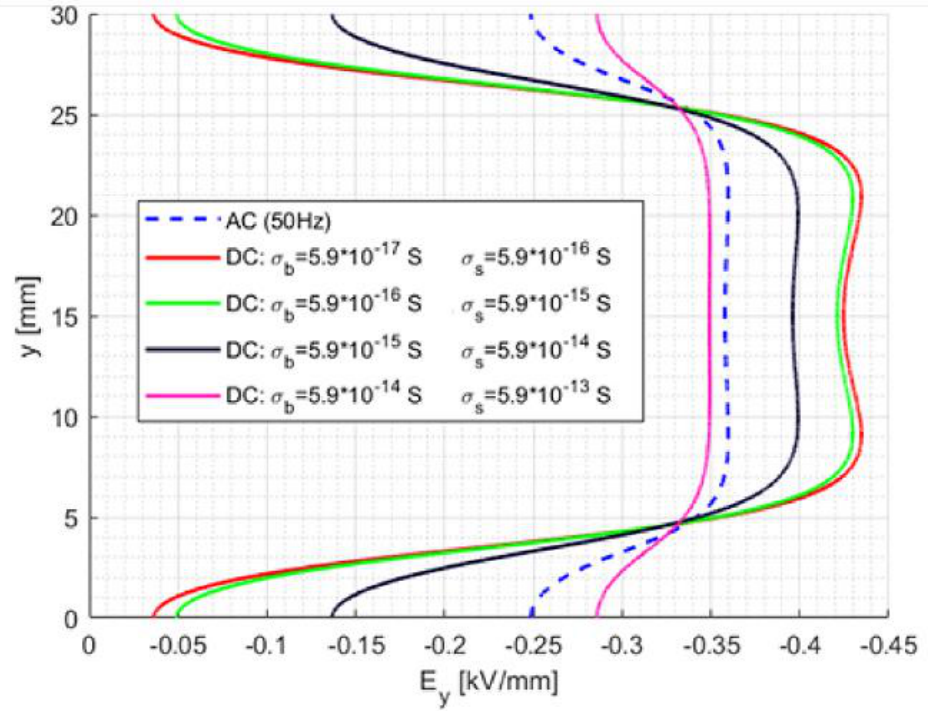
Figure 11. Tangential surface field for ac and for different conductivity values in dc steady-state.